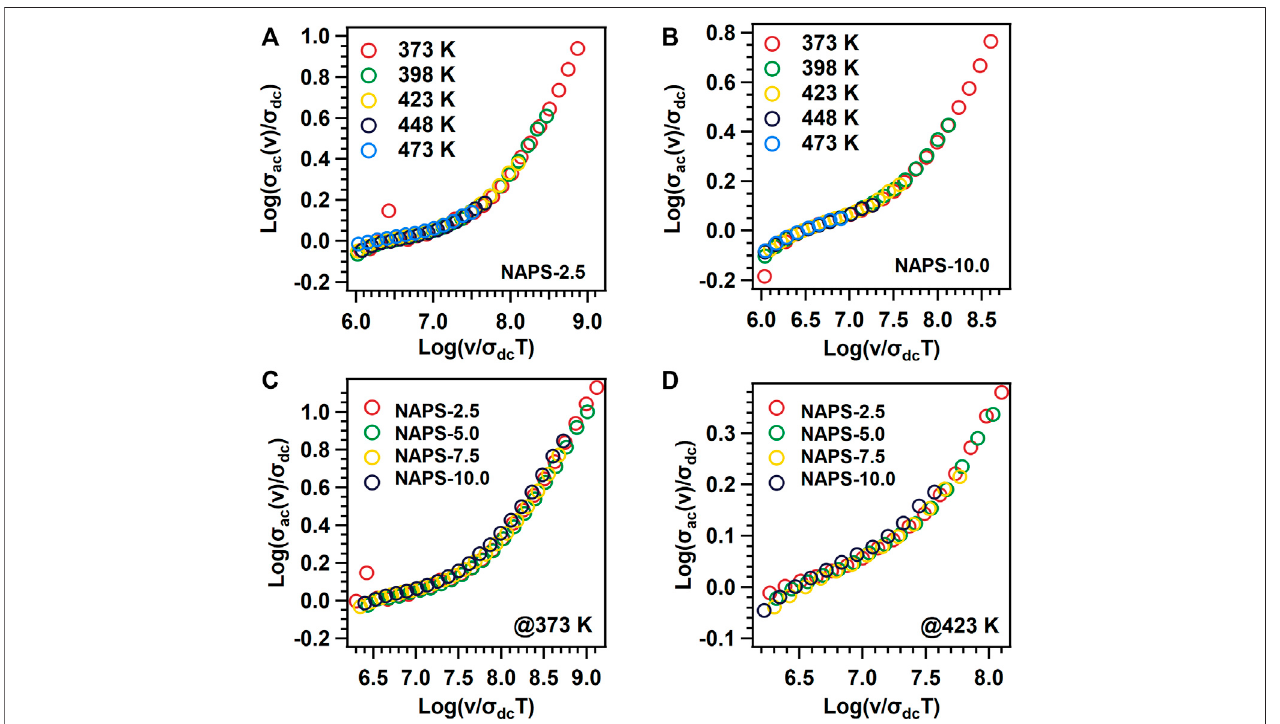
Frontiers in Materials |